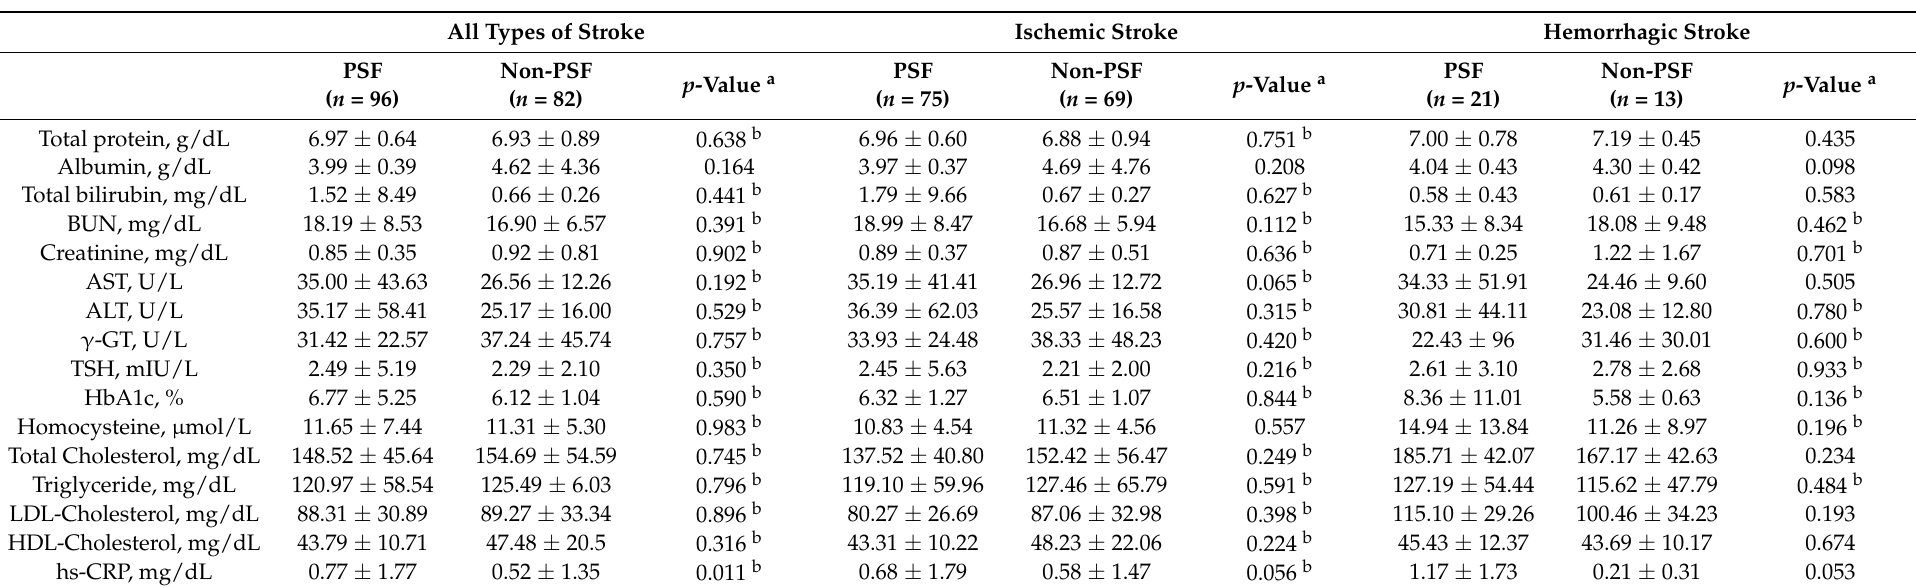
Table 3. Comparison of biochemical data between the PSF and non-PSF